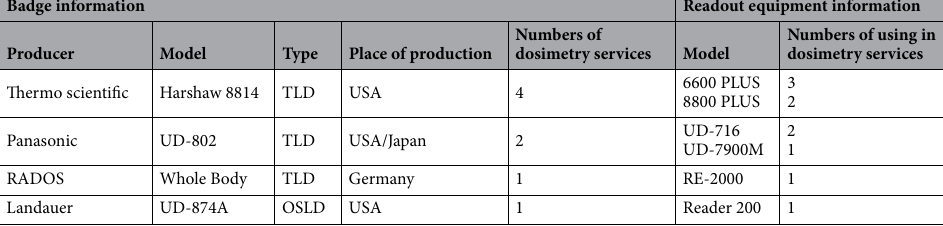
Table 1. The information within eight dosimetry services in Taiwan. TLD thermoluminescence dosimeter, OSLD optically stimulated luminescence